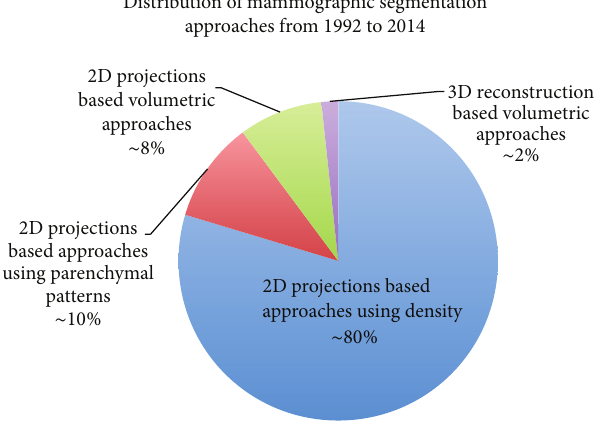
Figure 7: Distribution of various mammographic tissue segmenta- tion approaches from 1992 to 2014.